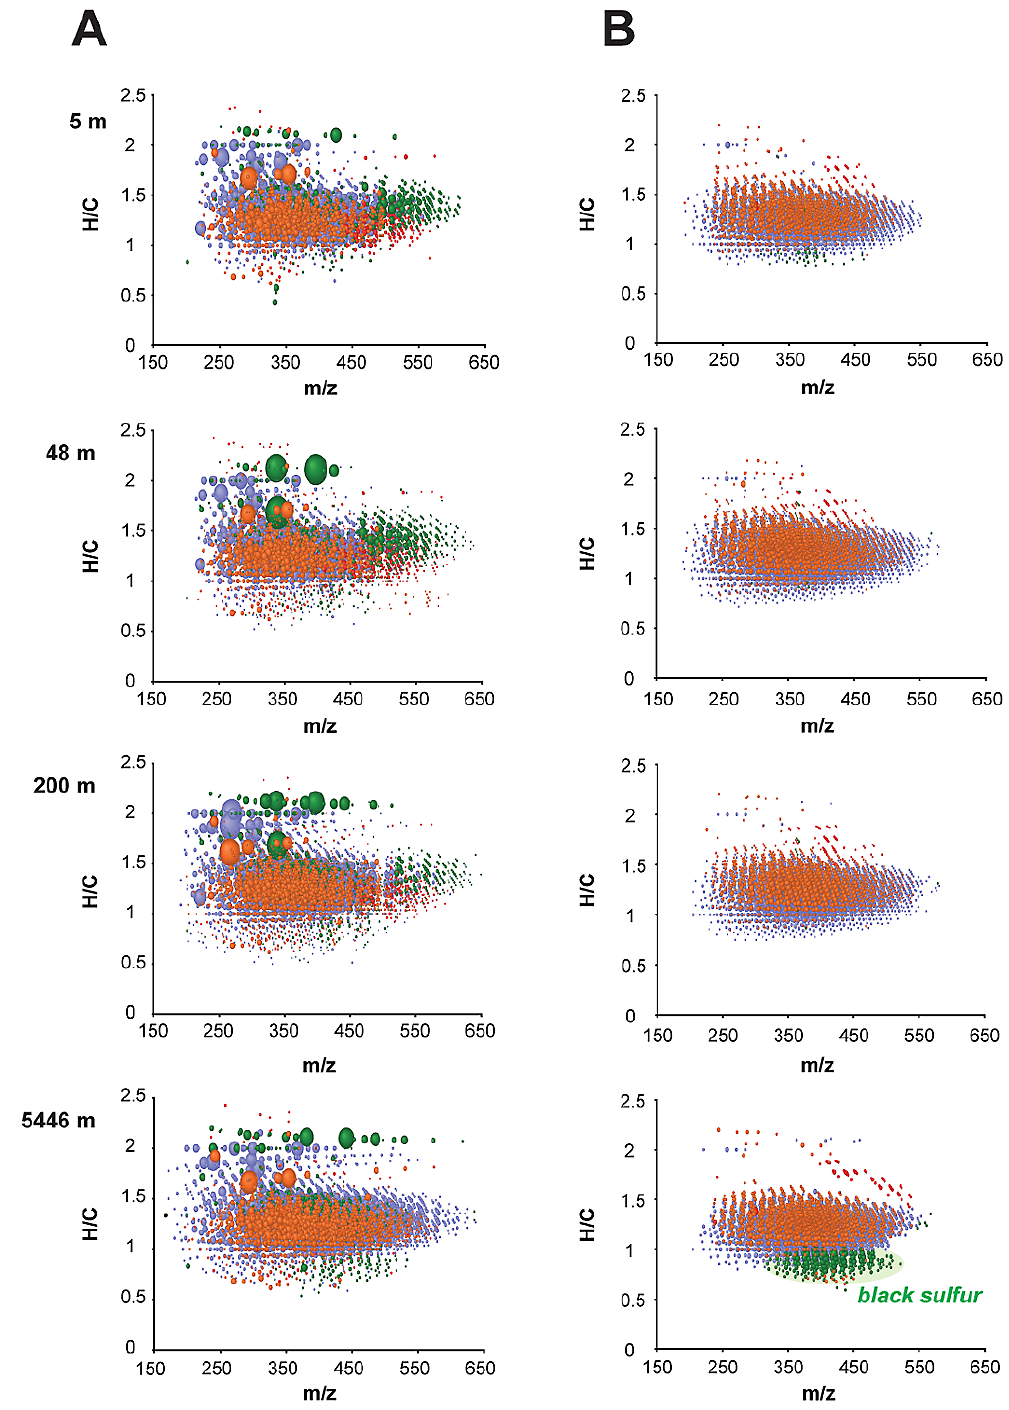
Fig. 16. Mass edited H/C ratios derived from (A) negative ESIFTICR mass spectra and (B) positive ESI FTICR mass spectra of marine SPE-DOM, assigned in all four marine SPE-DOM to CHO (blue), CHNO (orange), CHOS (green) and CHNOS (red) molecular series. Note the distinct series of aromatic CHOS compounds unique to abyssopelagic marine SPE-DOM at 5446m which is termed black sulphur because of its compositional characteristics (cf. text, Figs. 15 and